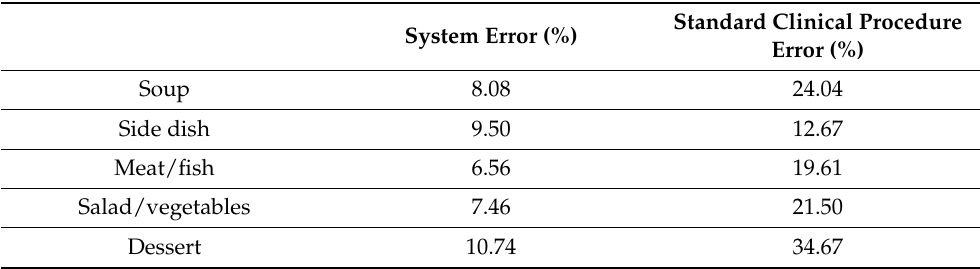
Table 4. Comparative results between the system and the nurse for consumed percentage for each food